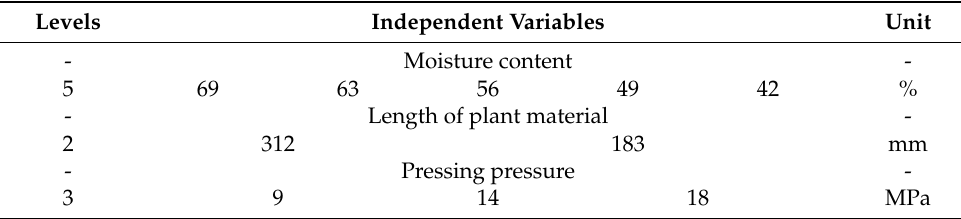
Figure 1. Experimental design. Table 1. Levels and values of the independent variables.